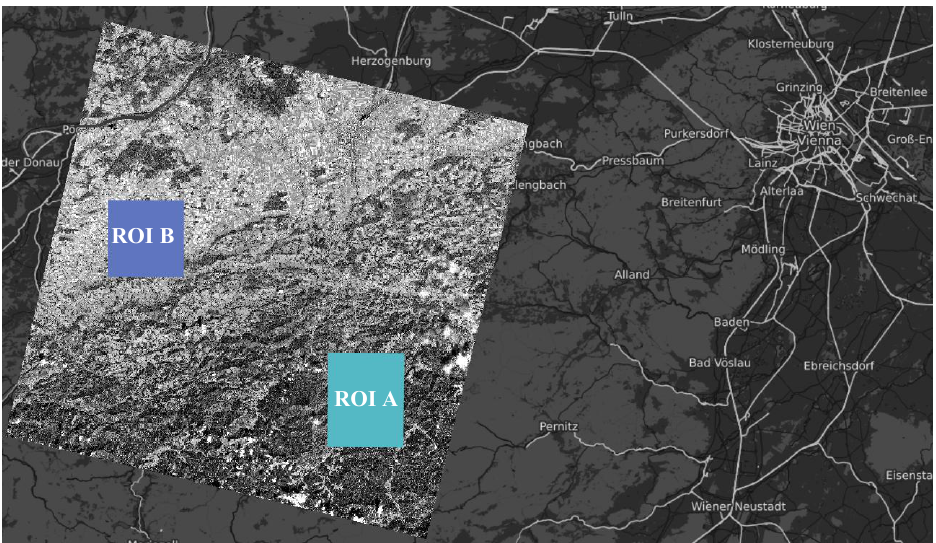
Figure 1. The two sites for image direct location accuracy evaluation in